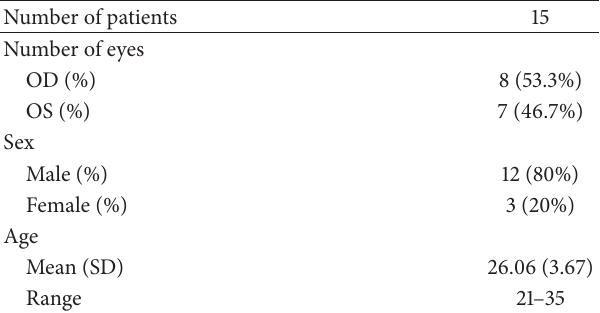
Table 2: Characteristic of